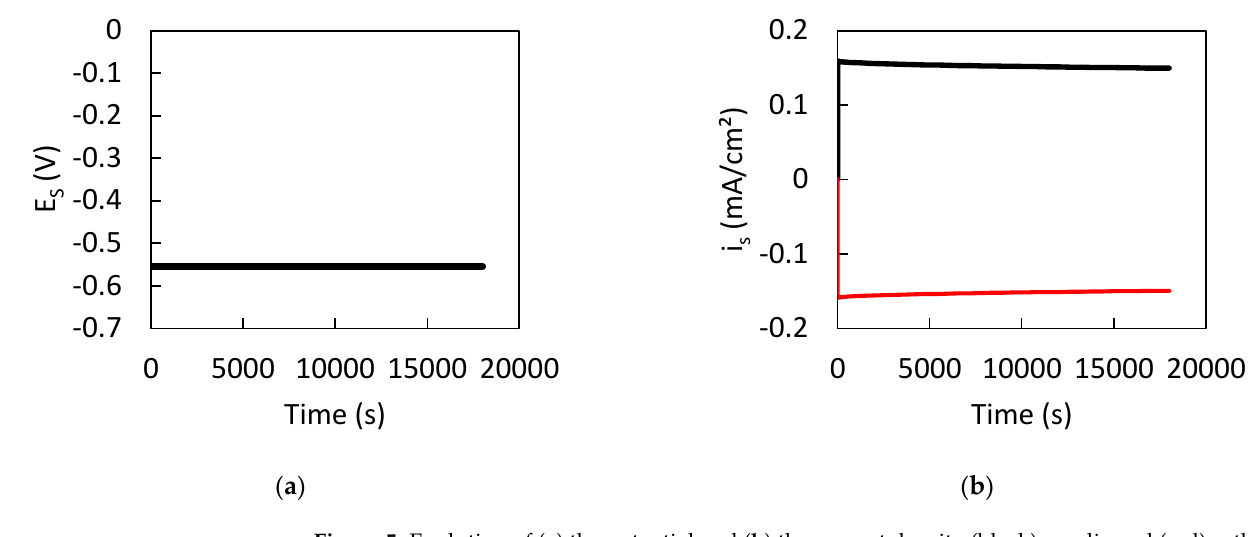
Figure 5. Evolution of ( a ) the potential and ( b ) the current density (black) anodic and (red) cathodic part at the surface of the electrode x = S.